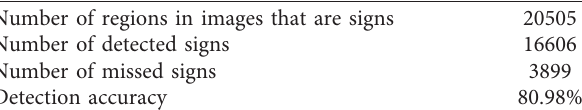
Figure 5: Examples of signs found and classified. Table 1: Summary of traffic sign detection results. Table 2: Summary of traffic sign classification results.